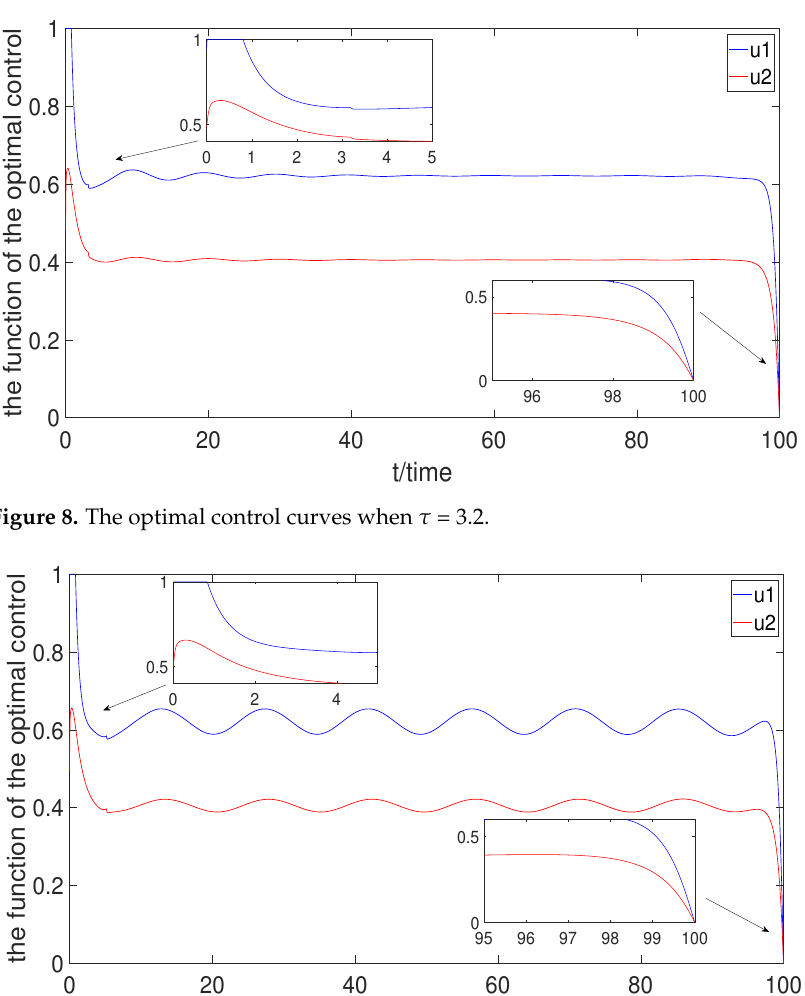
end of the optimal control